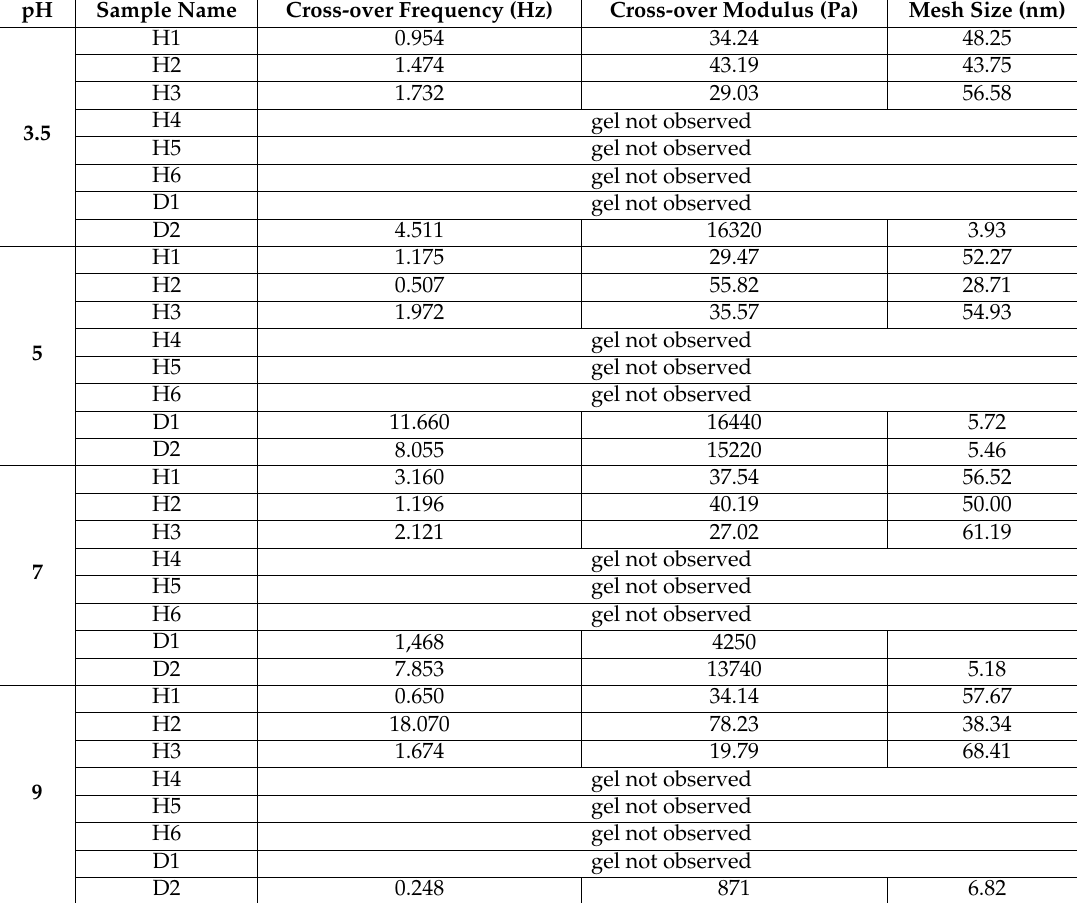
Table 4. Cross-over frequency and modulus, mesh size for all prepared hydrogels, pH influence. pH Sample Name Cross-over Frequency (Hz) Cross-over Modulus